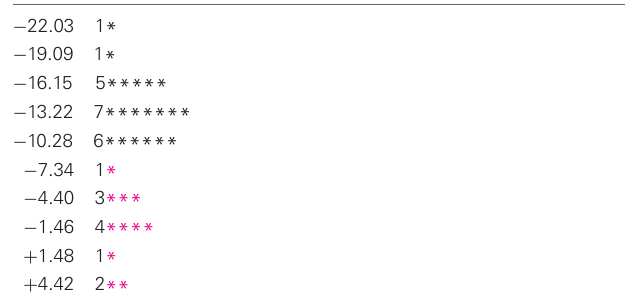
Table 1 | Histogram of values of the discriminant function − 0 . 28 · OM − 0 . 15 · GM + 0.55 · RL − 0.20 · EL for members of the motor-impaired (magenta) and motor-intact (black)